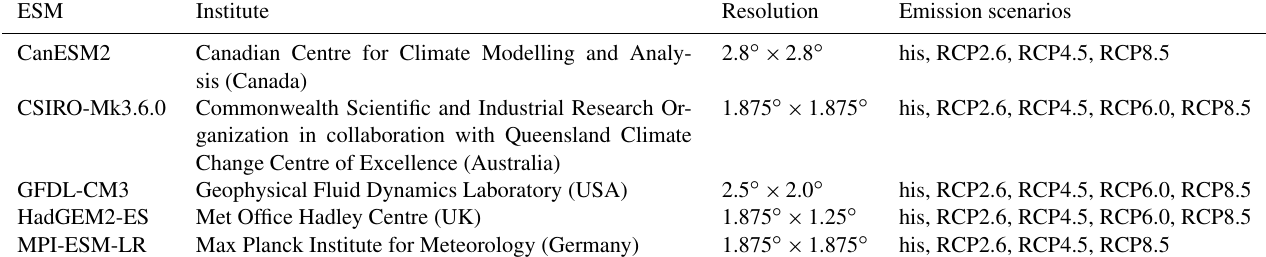
Table 1. Data used for future climate change scenario construction (his; historical).